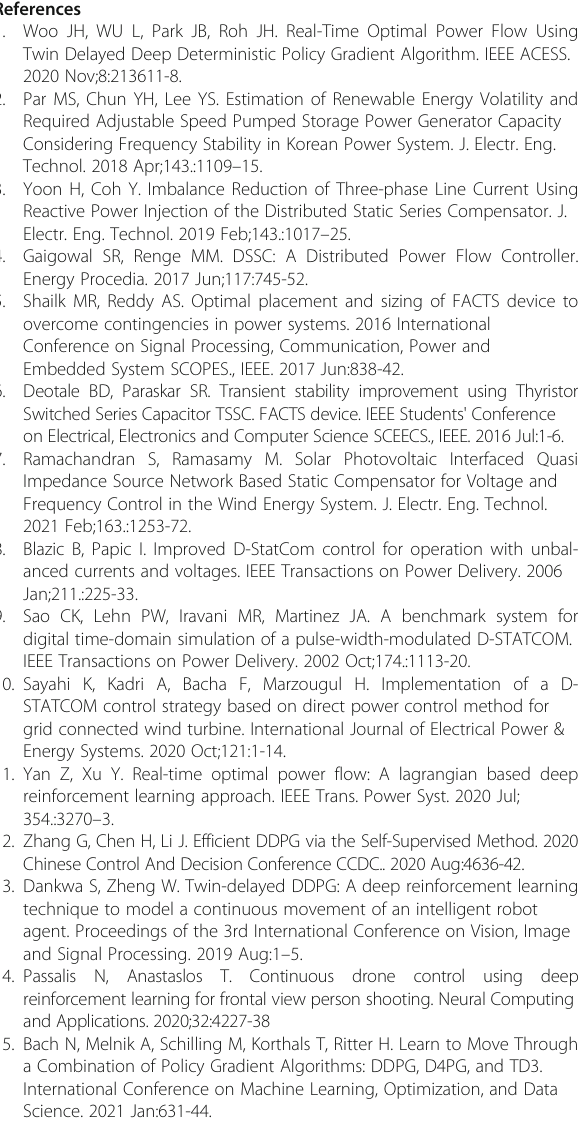
Fig. 1 (Abstract P5). IEEE-13 BUS real unbalanced distribution network